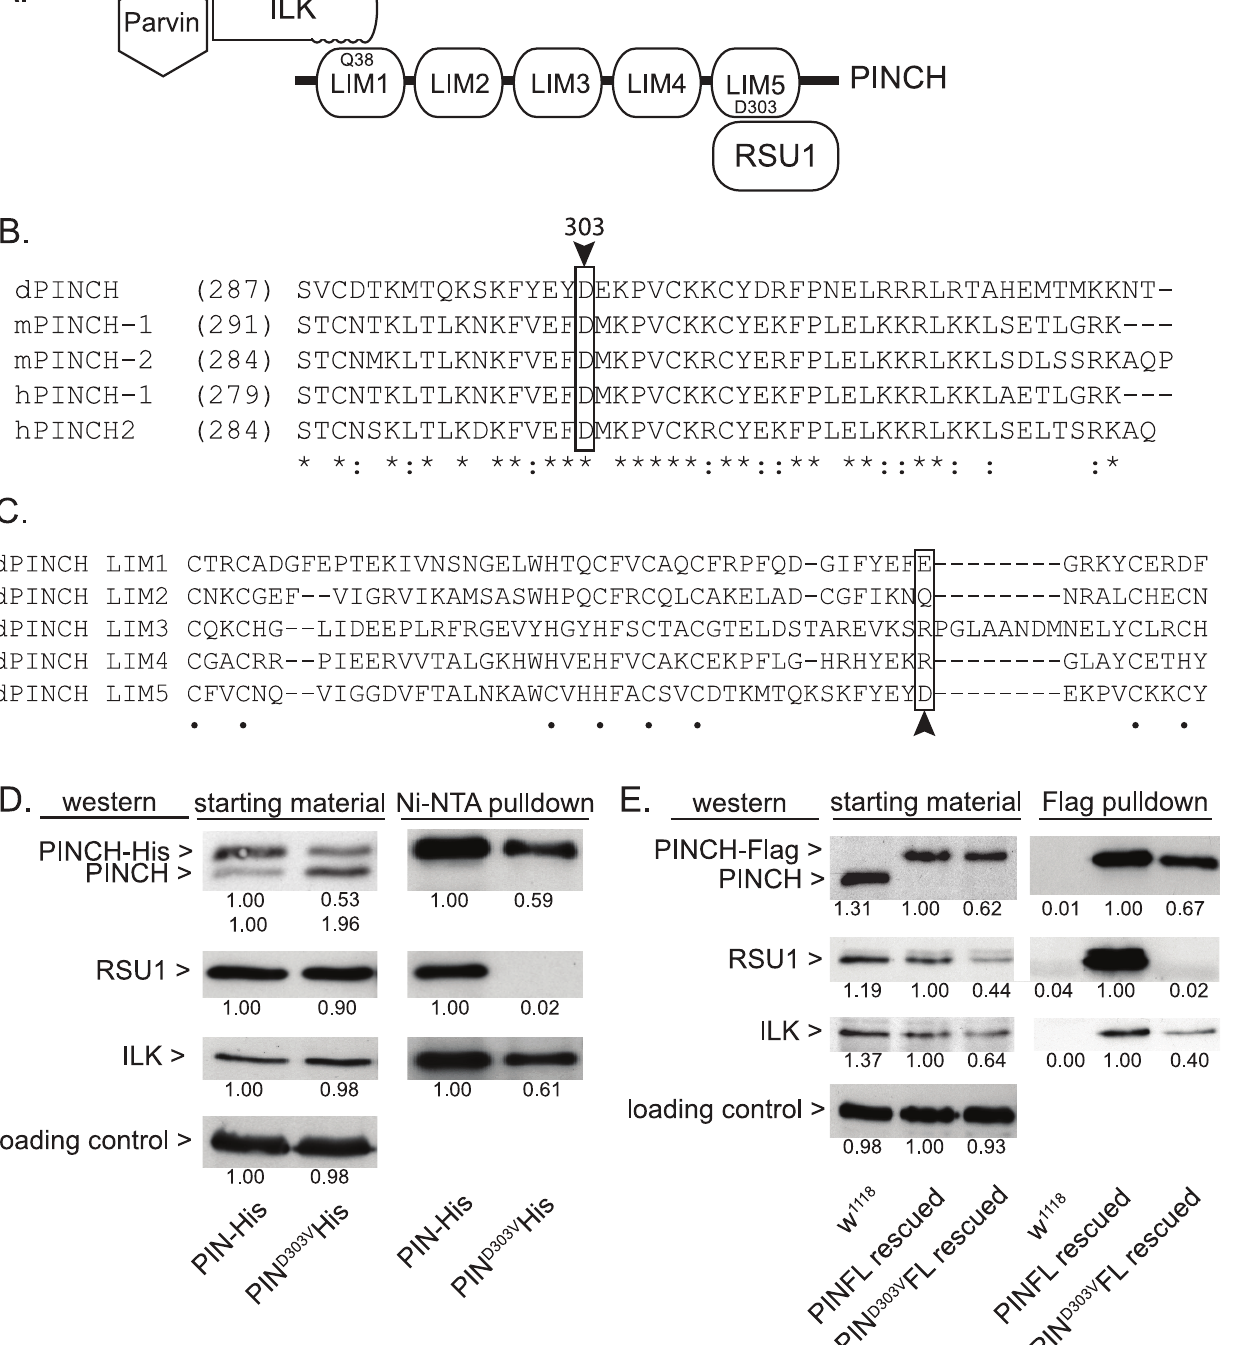
Figure 3. PINCH D303V mutation disrupts binding to RSU1. A) Schematic of PINCH showing its 5 LIM domain structure. The N-terminal ankyrin repeat of ILK binds to LIM1 of PINCH via PINCH Q38 . Parvin associates with PINCH indirectly via binding to the ILK pseudokinase domain. RSU1 binds to LIM5 of PINCH through PINCH D303 . B) Sequence alignment of the C-terminus of fly, mouse and human PINCH sequences demonstrates the conservation of D303 (boxed with arrowhead). Asterisks denote invariant residues, and colons denote conserved residues. C) Sequence alignment using the 5 individual LIM domains of Drosophila PINCH shows that D303 (boxed with arrowhead) is a variable residue within LIM sequences. Dots denote the zinc binding residues. D) Ni-NTA pull-downs of wild type PINCH-His and PINCH D303V His expressed in S2 cells show a disruption of RSU1 binding only in the D303V mutant while ILK binding is preserved. E) Flag immunoprecipitations of adult fly lysates from PINCH null mutants rescued with either wild type PINCH-Flag or PINCH D303V Flag transgenes. w 1118 is used as a negative control that does not express Flag. ILK, RSU1 and a PINCH transgene are all expressed in the starting material. PINCH D303V Flag pulls down ILK but fails to co-precipitate RSU1. In both D and E, densitometric analyses were conducted to compare levels of protein between samples and quantification is provided below each blot. a -tubulin was used as a loading control and values for PINCH, RSU1 and ILK were adjusted to account for variation in loading. doi:10.1371/journal.pgen.1003406.g003 PLOS Genetics |